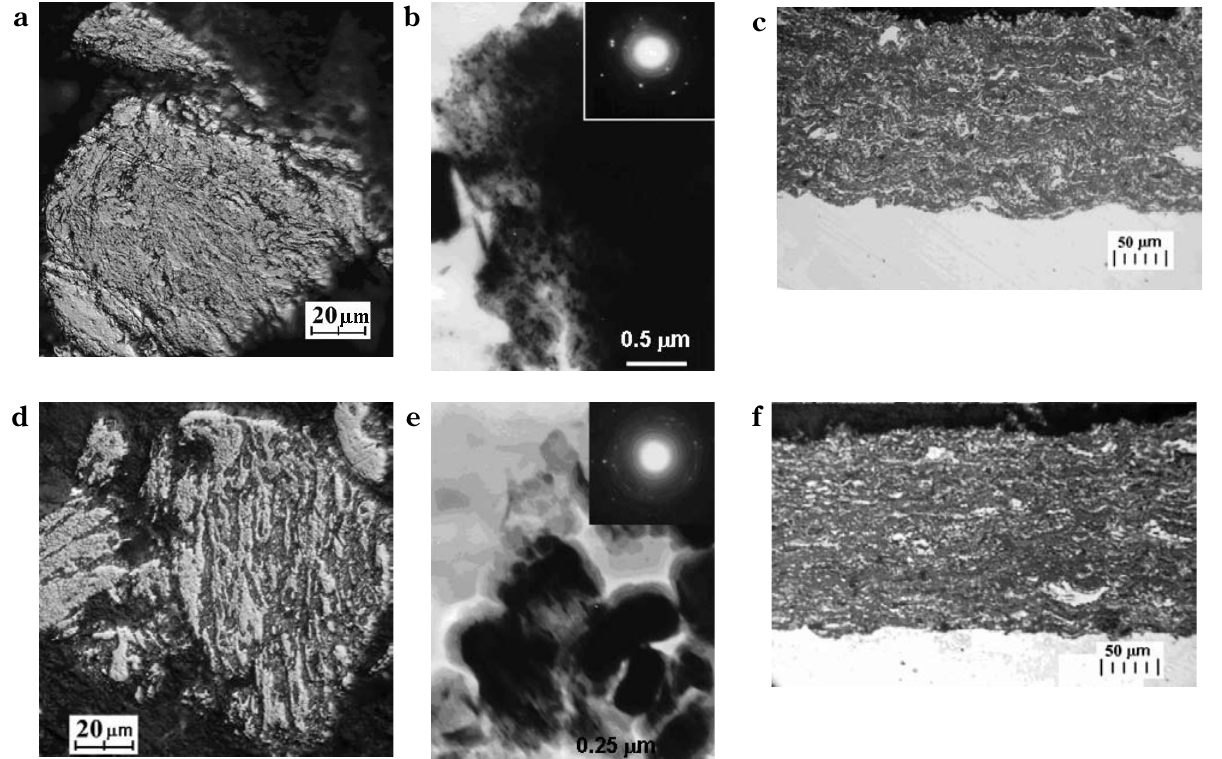
Fig. 12 Microstructure of nanocomposite SHS powders (a-b, d-e) and detonation spray coatings from them (c, f): a-c – FeAl / Al 2 O 3 powder; d-f – FeAl(Cr) / Al 2 O 3